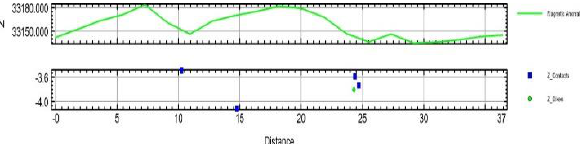
Figure 20: Total magnetic intensity profile for traverse 3 location